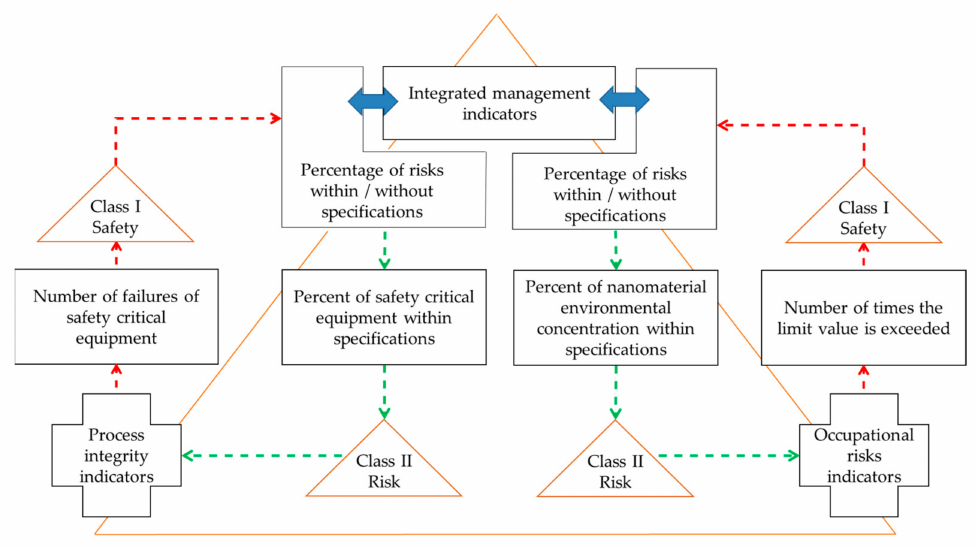
Figure 4. Case study: Integration of leading and lagging indicators in an IMS (Own